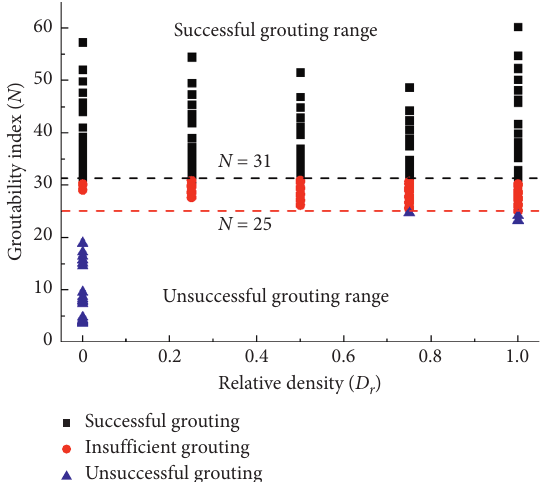
Figure 7: The relation between the groutability index N and the groutability of sand layer.